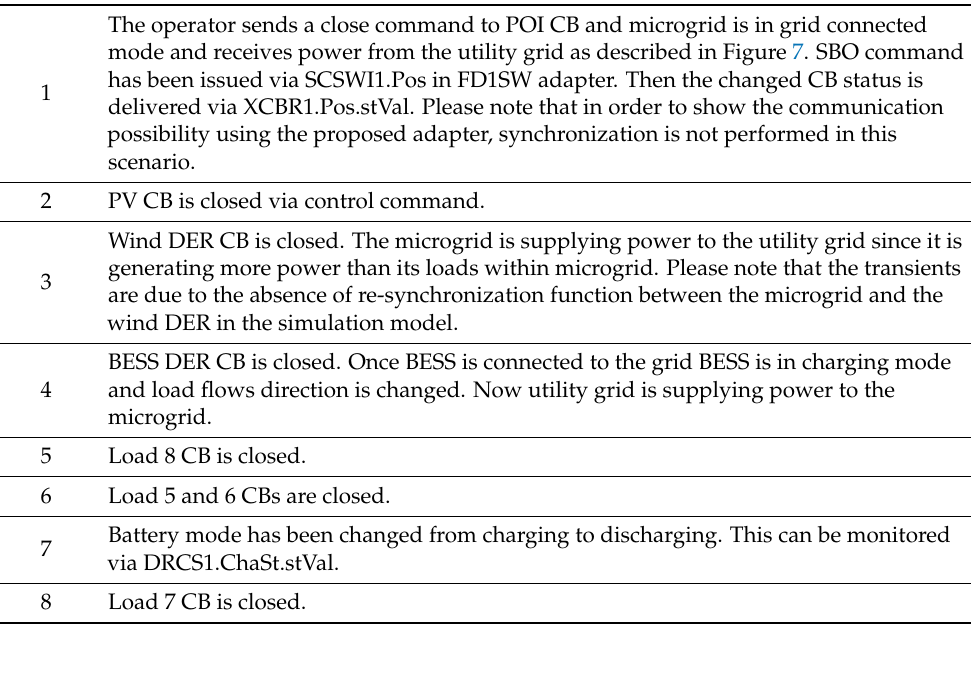
Table 2. Validation of IEC 61850 Adapter.